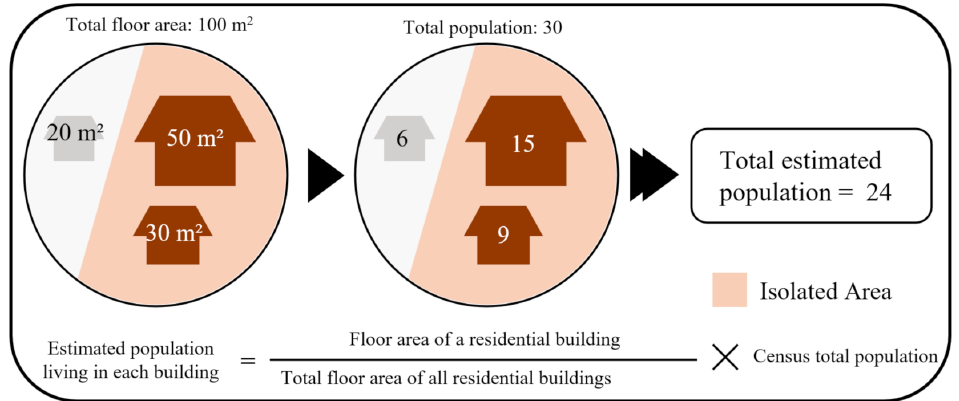
Figure 4. Estimating the population in an isolated